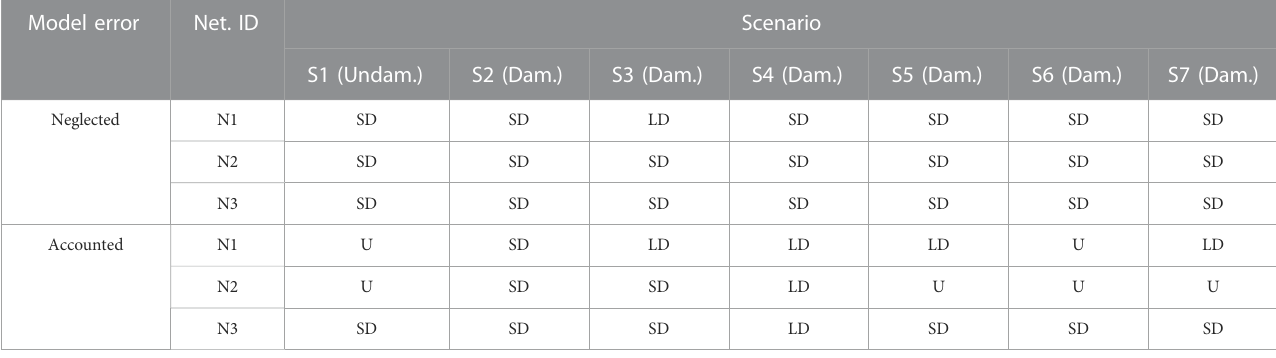
TABLE 5 Numerical case study: results of the test with model R considering or not the model error. U: undamaged condition; SD: severe damage; LD: light damage. Model